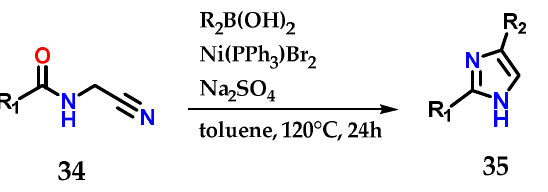
Figure 16. Nickel-catalyzed cyclization of amido-nitriles 34 to obtain disubstituted imidazoles 35 .